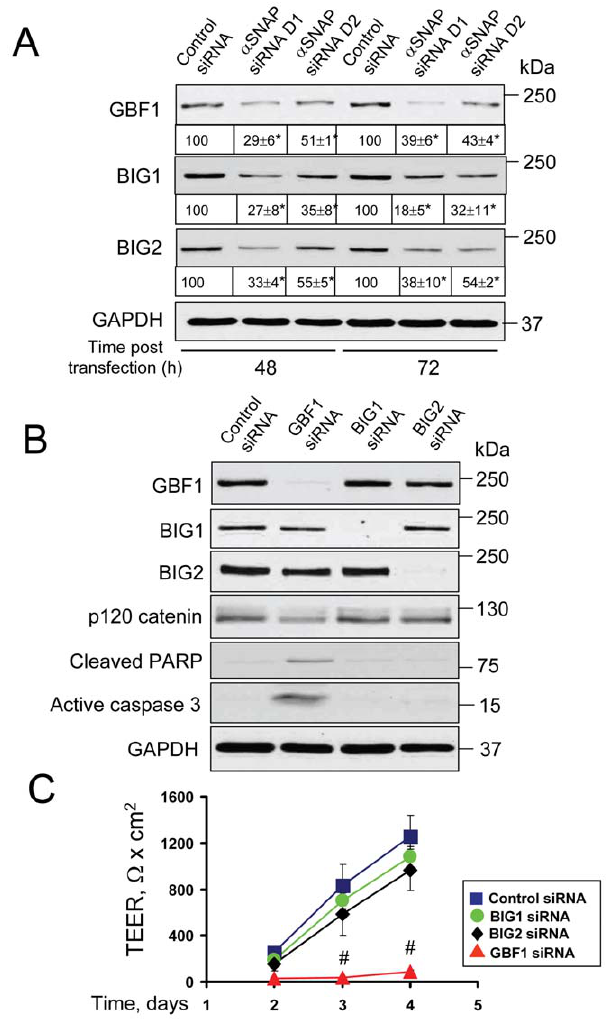
Figure 9. GBF1, but not other Golgi GEFs, regulates barrier functions of the intestinal epithelial junctions. ( A ) Immunoblot- ting analysis demonstrates that two different a SNAP-specific siRNA duplexes significantly decrease expression of Golgi GEFs, GBF1, BIG1 and BIG2 in SK-CO15 cells on days 2 and 3 post-transfection. ( B,C ) SK- CO15 cells were transfected with either control GBF1, BIG1, or BIG2, siRNAs and examined on day 4 post-transfection. Immunoblotting analysis demonstrates selective down regulation of individual GEFs by their gene-specific siRNAs. Depletion of GBF1, but not BIG1 or BIG2, decreased p120 catenin expression ( B ), dramatically inhibited develop- ment of the paracellular barrier ( C ) and induced apoptosis ( B ); *p , 0.05, # p , 0.01 compared to control siRNA-transfected